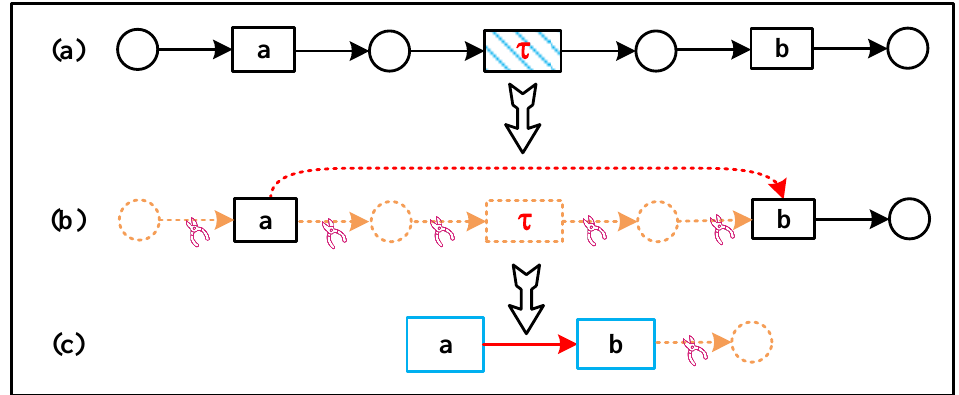
Figure 5. Handling the invisible transitions in Petri nets.